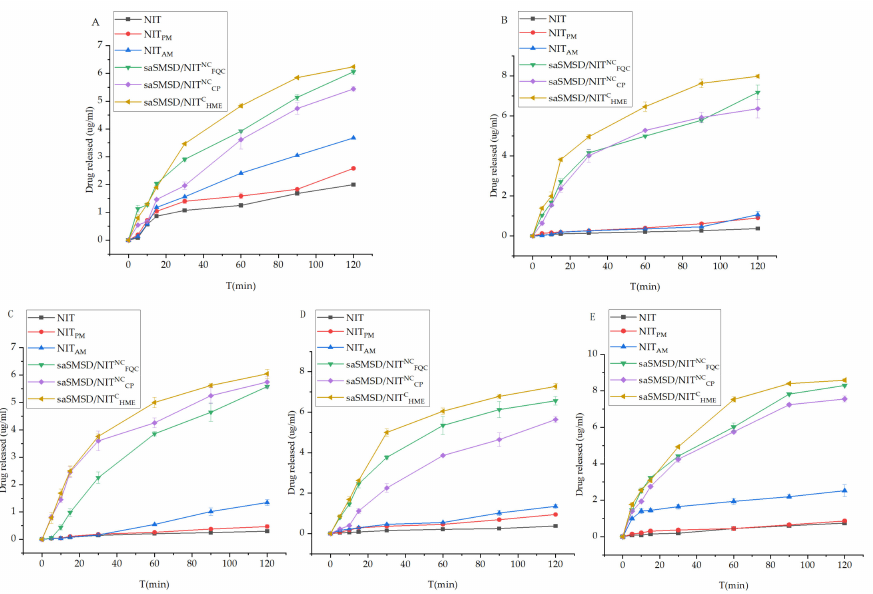
Figure 5. ( A ) Dissolution profiles of NIT, NIT PM , NIT AM , saSMSD/ NIT NC FQC , saSMSD/ NIT NC CP